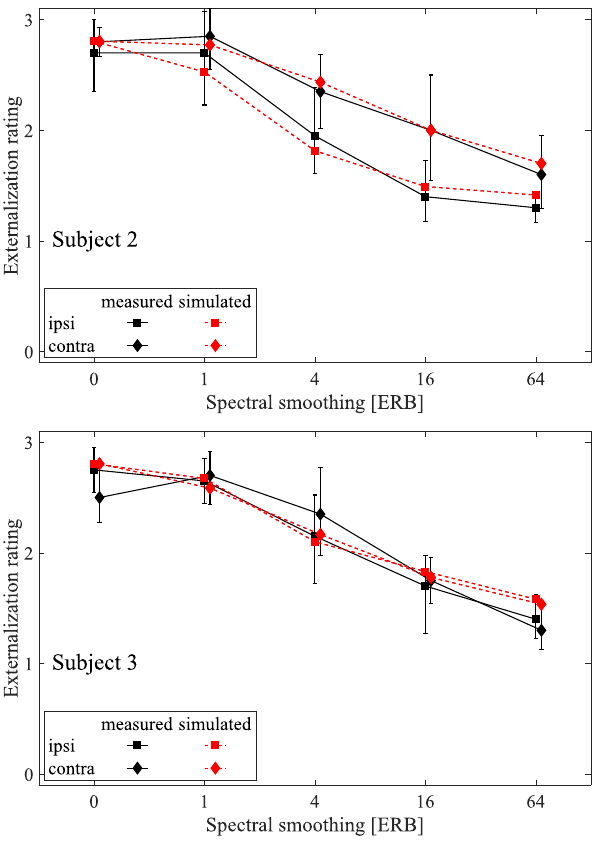
Figure 10. Median values of externalization ratings and the predicted results of subject 2 (upper panel) and subject 3 (lower panel) for smoothed spectral information in the HRTF ( “ contra ” and “ ipsi ” conditions in Experiment D). All other conventions are as in Figure 2.